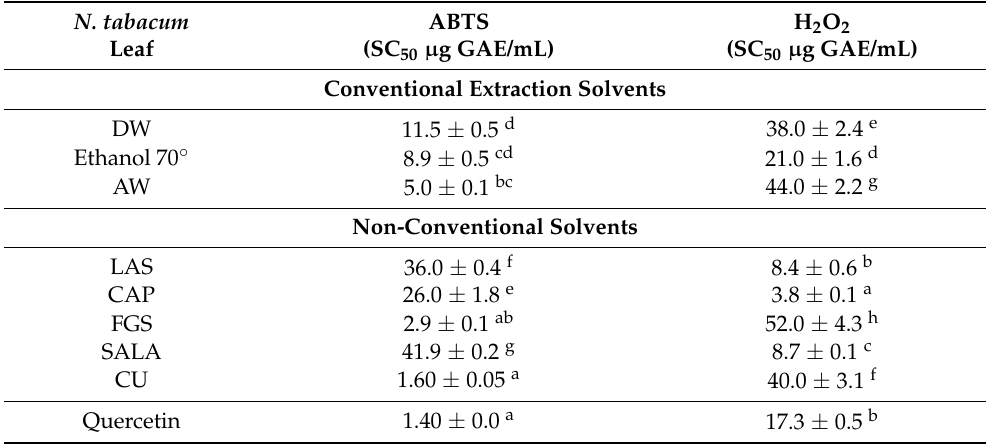
Table 5. Antioxidant activity of Nicotiana tabacum var. Virginia leaf waste powder